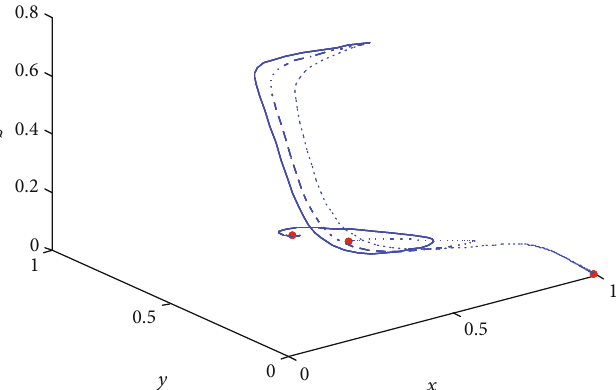
= 0 : 1, 0 : 5, and 0 : 75 , those represented by 6